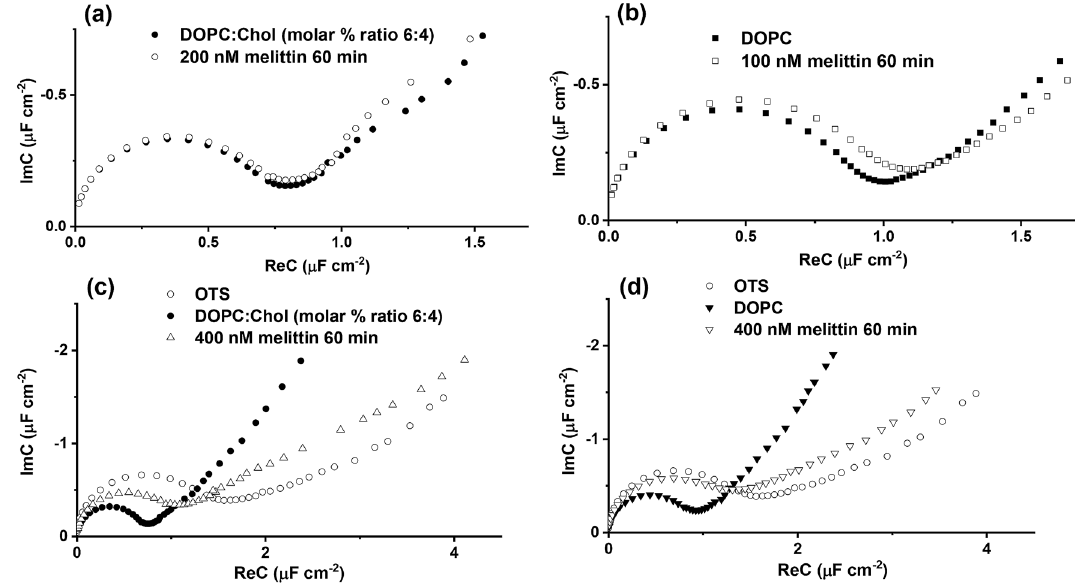
Figure 6. Electrochemical impedance spectra in Cole–Cole plot of melittin interaction: ( a ) and ( c )—with DOPC:Chol (molar % ratio 6:4), ( b ) and ( d )—with DOPC hybrid bilayer lipid membranes. The applied potential: − 0.7 V versus Ag/AgCl/NaCl (sat.)